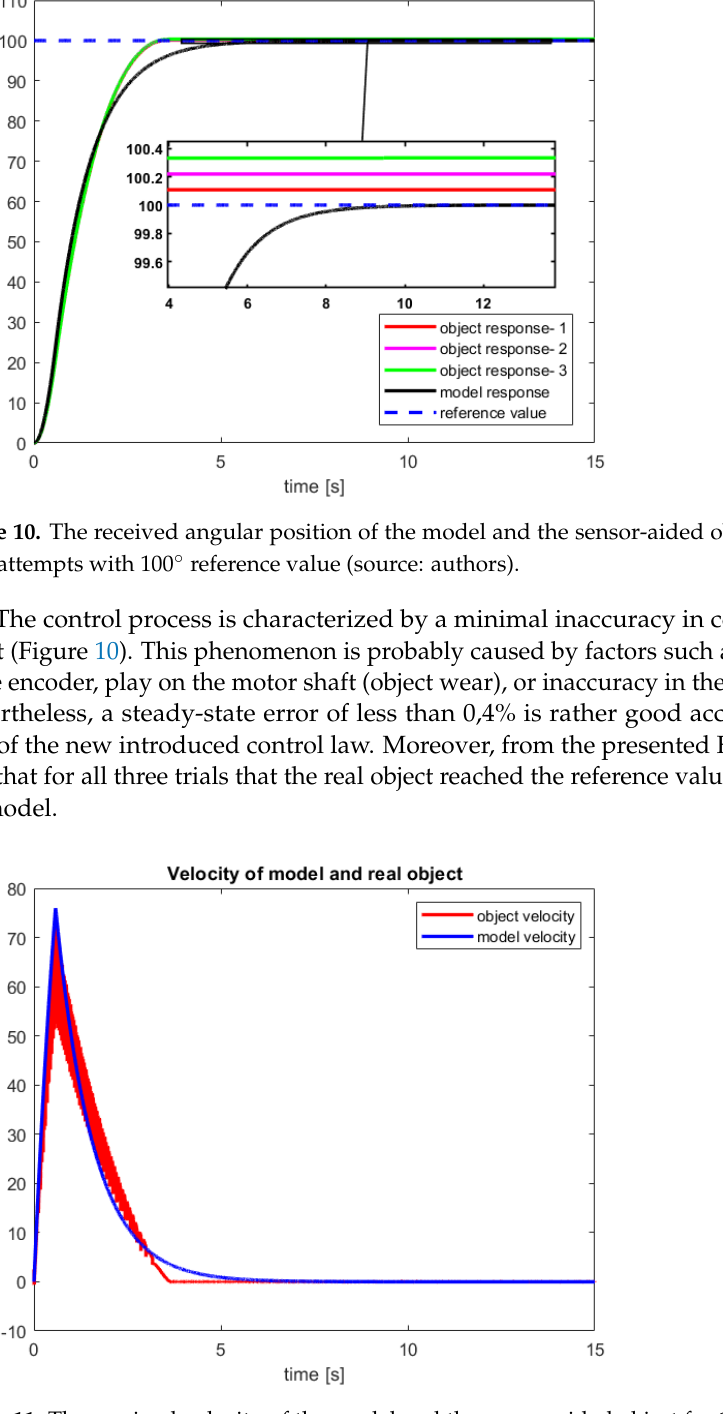
Figure 11. The received velocity of the model and the sensor-aided object for 100 ◦ reference value (source: